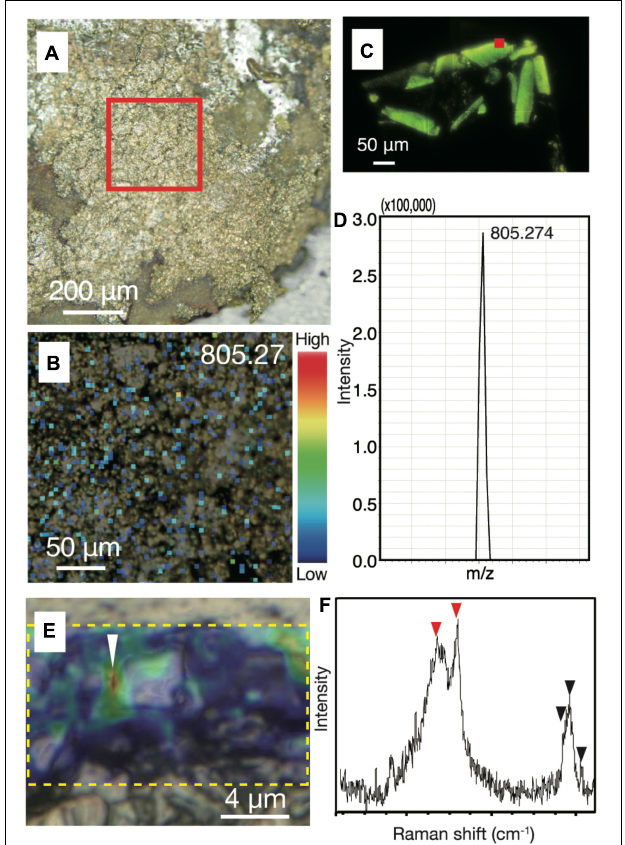
and Raman spectroscopy from chalcopyrite grain boundaries. (A) Reflection light microscope image of inner chalcopyrite wall. The red square highlights the region observed at a higher magnification in Figure 3B . (B) Mapping image of a macromolecule at with m/z = 805.27 by imaging mass spectrometry analysis with an intensity color contour. (C) Fluorescence microscopy image of a DNA-stained section from cultured cells of an archaeon ( Thermococcus kodakarensis ). The red square indicates a spot where a mass spectrum was obtained. (D) Mass spectrum focusing on a peak at m/z = 805.274 obtained from the spot indicated by the red square in Figure 3C . (E) Optical microscope image overlapped with a Raman spectroscopy mapping image of the peak intensity at 2,800–3,000 cm - 1 , as highlighted by a yellow dotted rectangle. (F) Raman spectrum obtained from the region indicated by a white arrow in Figure 3E . Red arrows indicate peaks not found in the resin or minerals spatially associated with the small spheres, while back arrows indicate peaks also found in the resin ( Supplementary Figures 5 , 6